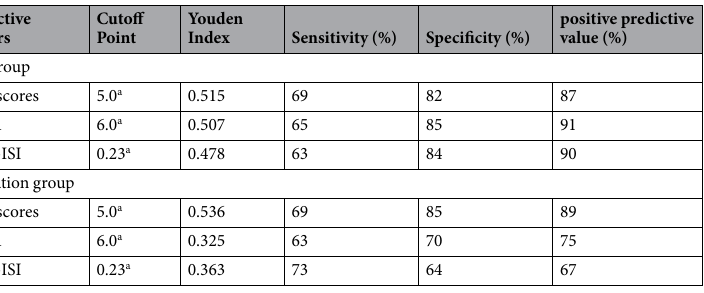
Table 8. Comparison of new scores, SOFA and ATN-ISI in predicting 90-day mortality after AKI diagnosis according to Youden index. Abbreviation: AKI, acute kidney injury; ATN-ISI: acute tubular necrosis-individual severity index; SOFA: sequential organ failure assessment; a Value giving the best Youden index.